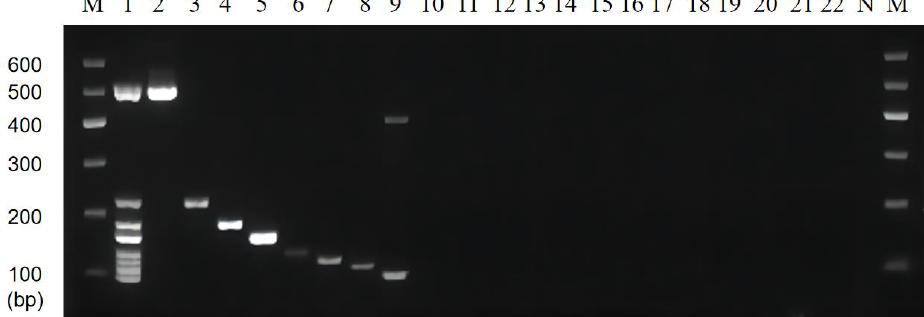
Figure 6. Results of multiplex PCR specificity. Lane M: DNA marker B 600; Lane 1: Mixed 8 target DNA as templates; Lane 2~22: The DNA templates were P. putida , V. vulnificus , C. sakazakii , L. mon-